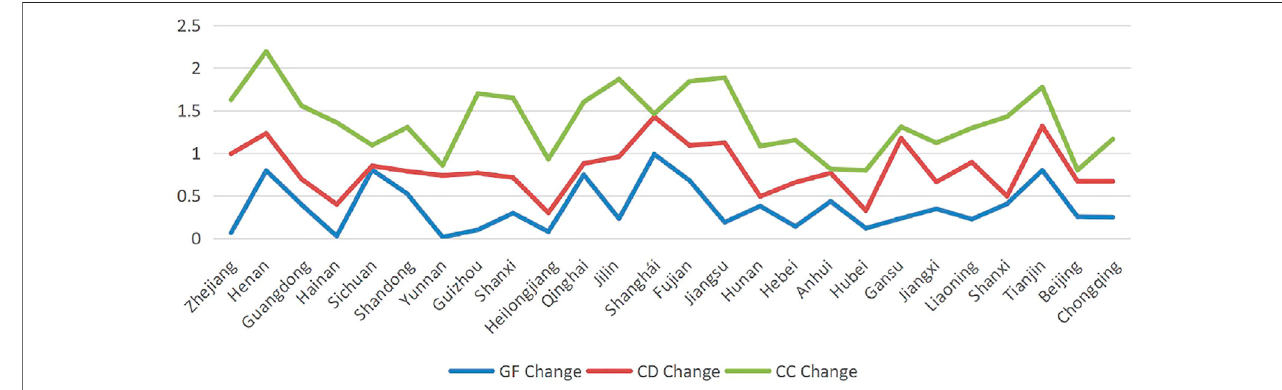
FIGURE 1 | Change in study constructs over the period of 2016 – 2020.